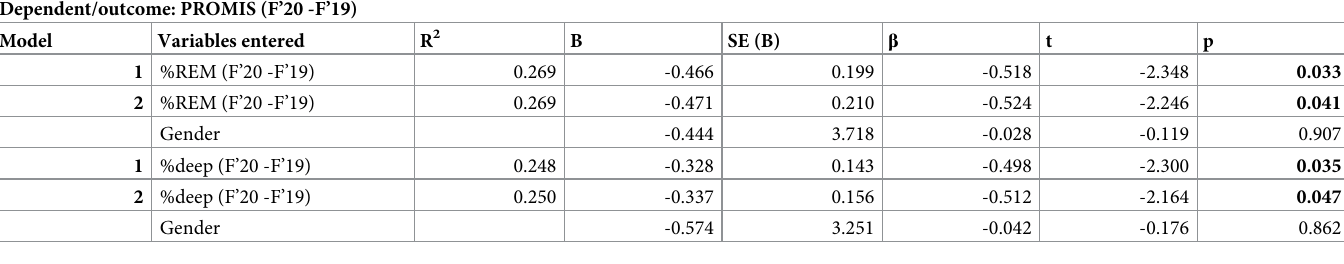
Table 4. Regression analysis of differences between mid- and pre-pandemic sleep disturbance (PROMIS) (as outcome) and Fitbit sleep measures (REM and deep sleep). Dependent/outcome: PROMIS (F’20 -F’19)